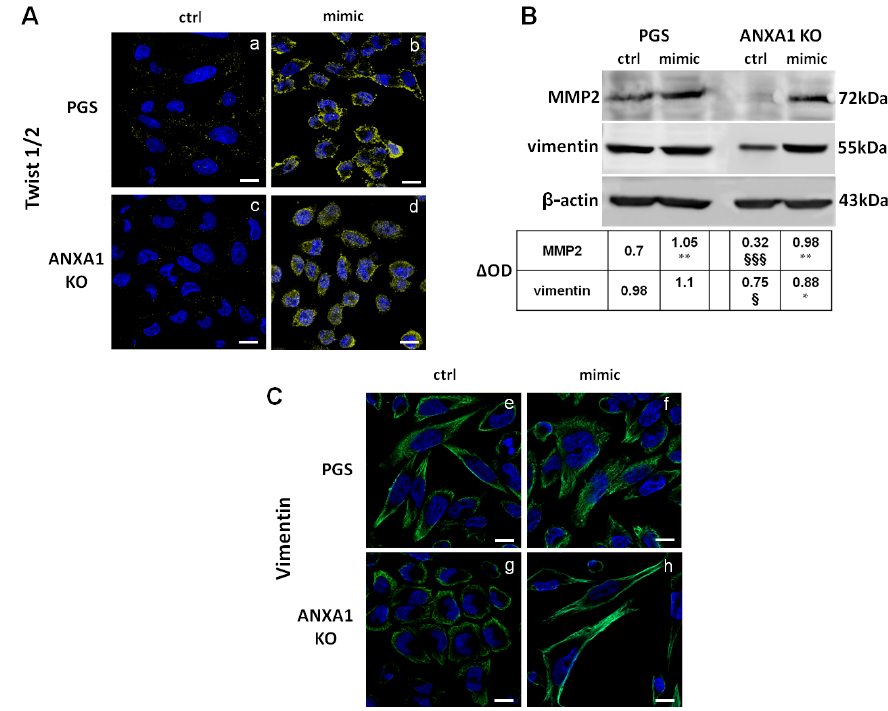
Figure 4. ( A ) Immunofluorescence analysis to detect Twist 1/2 (yellow) activation following the effects of miR-196a-5p mimic of PGS (panels ( a ) and ( b )) and ANXA1 KO cells (panels ( c ) and ( d )). Nuclei were stained in blue with Hoechst 33342. Magnification 63 × 1.4 NA. Bar = 10 µm; ( B ) Western blot of MMP2 and vimentin expression in PGS and ANXA1 KO MIA PaCa-2 cells in presence or not of miR-196a-5p mimic. All protein levels are normalized on β -actin levels. For densitometry analysis, the blots were exposed to Las4000 (GE Healthcare Life Sciences, Buckinghamshire, UK) and the relative intensities of bands were determined using ImageQuant software (GE Healthcare Life Sciences, Buckinghamshire, UK). * p < 0.05, ** p < 0.01 mimic treated vs. not treated cells. § p < 0.05, §§§ p < 0.001 ANXA1 KO vs. PGS MIA PaCa-2 cells; and ( C ) Immunofluorescence for vimentin (green) on PGS (panels ( e ) and ( f )) and ANXA1 KO cells (panels ( g ) and ( h )) treated or not with mimic. Magnification 63 × 1.4 NA. Bar = 10 µ m. Cells have been harvested after 48 h of transfection. Data are representative of three experiments with similar